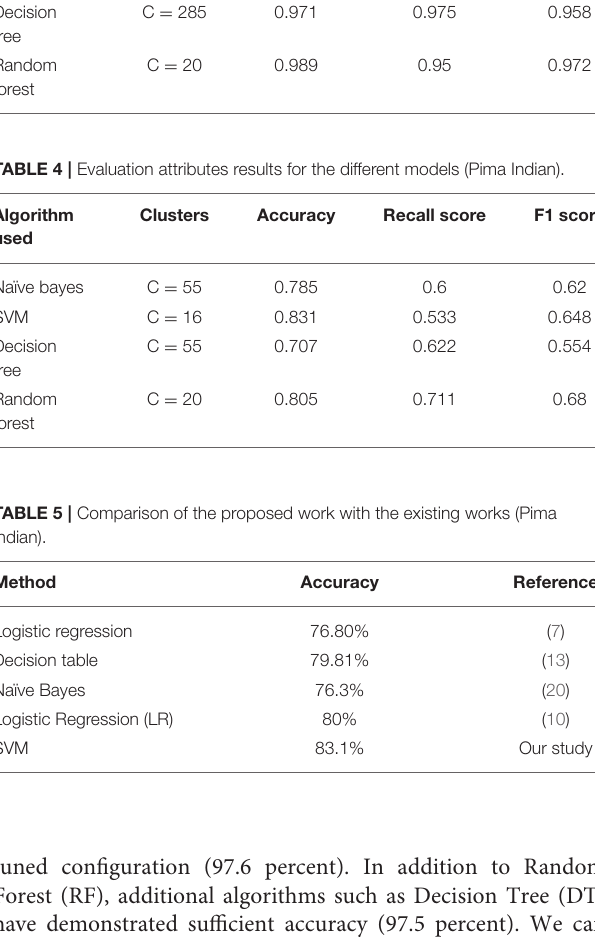
A Classification Algorithm-Based Hybrid Diabetes Prediction Model